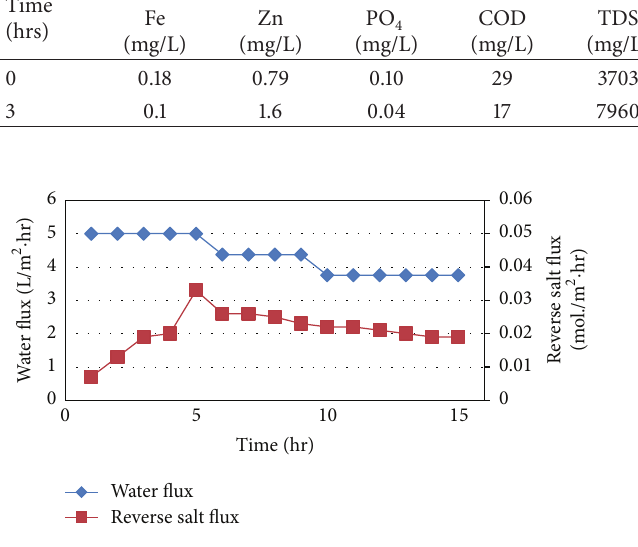
Figure 12: FO water and reverse solute fluxes as a function of time for FO/RO continuous